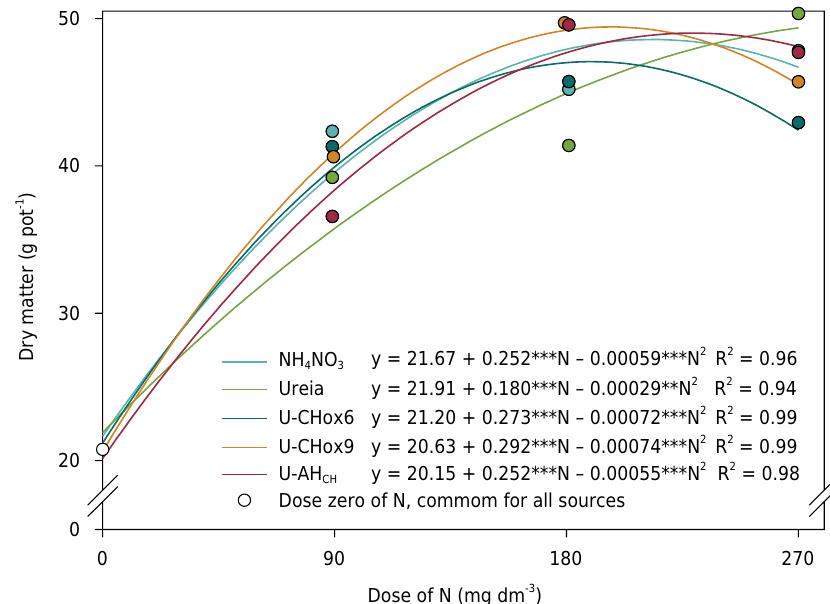
Figure 1. Dry matter yield of corn plants as a function of N dosages applied as NH 4 NO 3 , urea, and urea mixed with functionalized charcoals (U-CHox6 or U-CHox9) or humic acids derived from CHox (U-AH CH ). Equations representing the observed values are shown for p<0.01 (***) and p<0.05 (**).